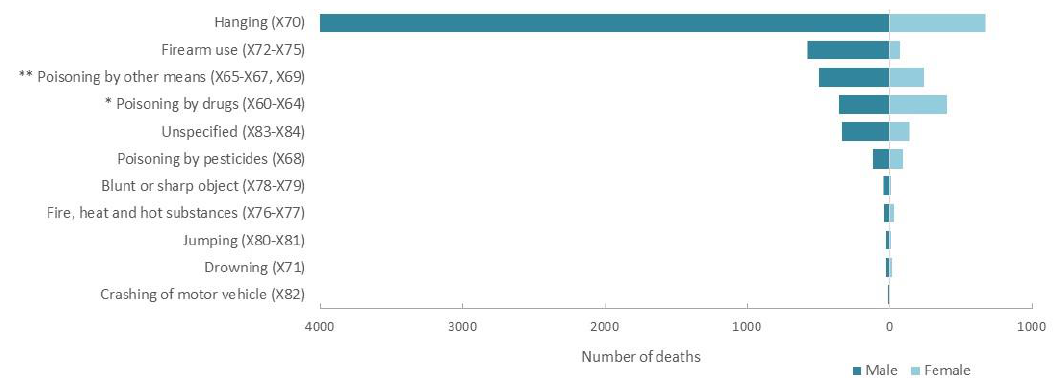
Figure 4. Number of deaths by method of suicide, 1997 to 2016. * Drug poisoning include medication